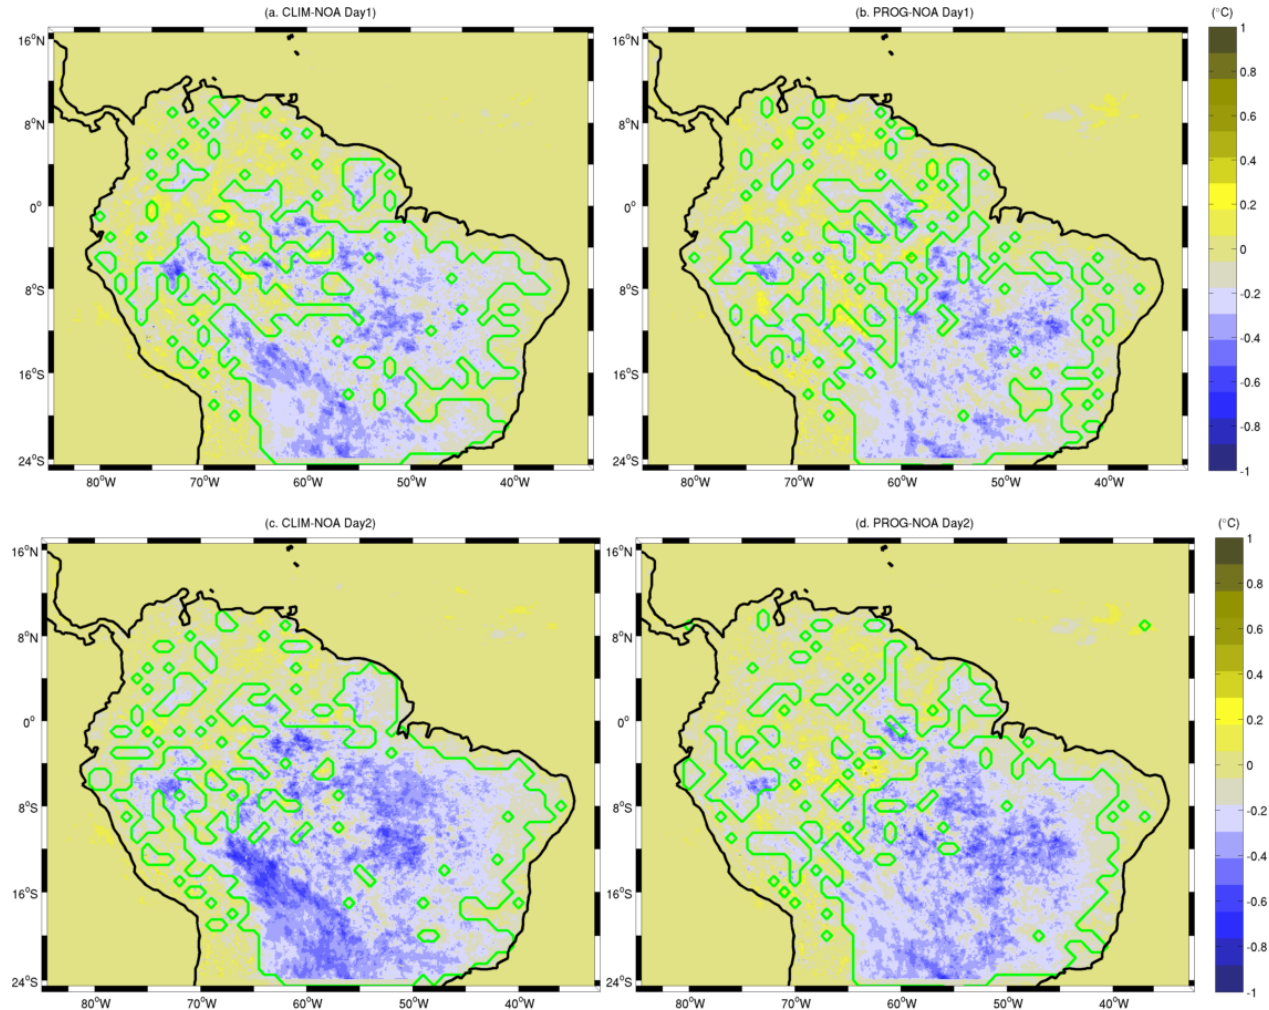
Figure 5. Impact of BBA on 2m air temperature for day 1 (a, b) and day 2 (c, d) . Green contour shows where BBA impacts are greater than the standard error.